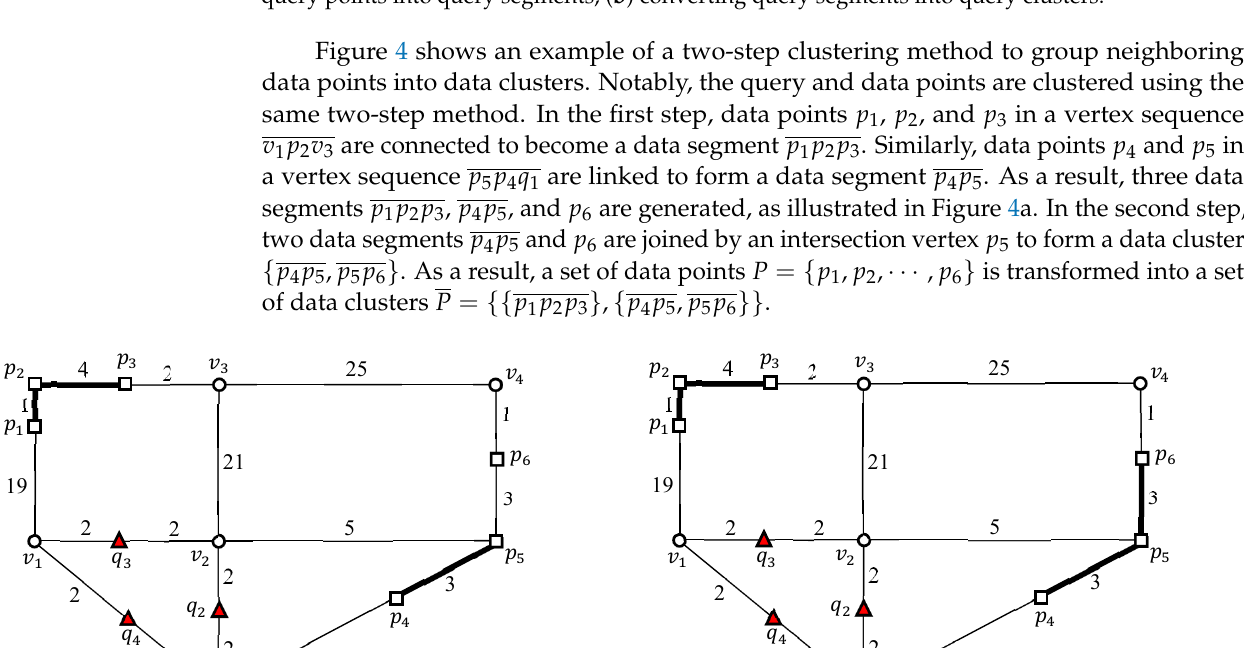
Figure 3. Two-step clustering method to group nearby query points into query clusters: ( a ) converting query points into query segments; ( b ) converting query segments into query clusters.